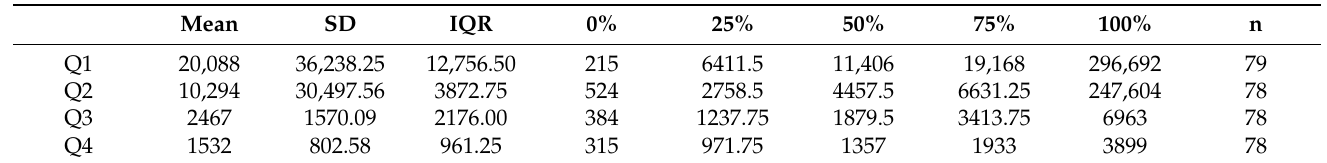
Figure 2. Rate of women over 64 years of age who are victims of gender-based violence by their current or past partner. Information by municipalities (2020) (Rate per 1000 inhabitants). Own elaboration based on data from the Ministry of Equality and the Center for Sociological Research CIS. Table 2. Population (inhabitants). Sources: own elaboration based on data from the Galician Institute of Statistics (IGE), Municipal Register of Inhabitants, the year